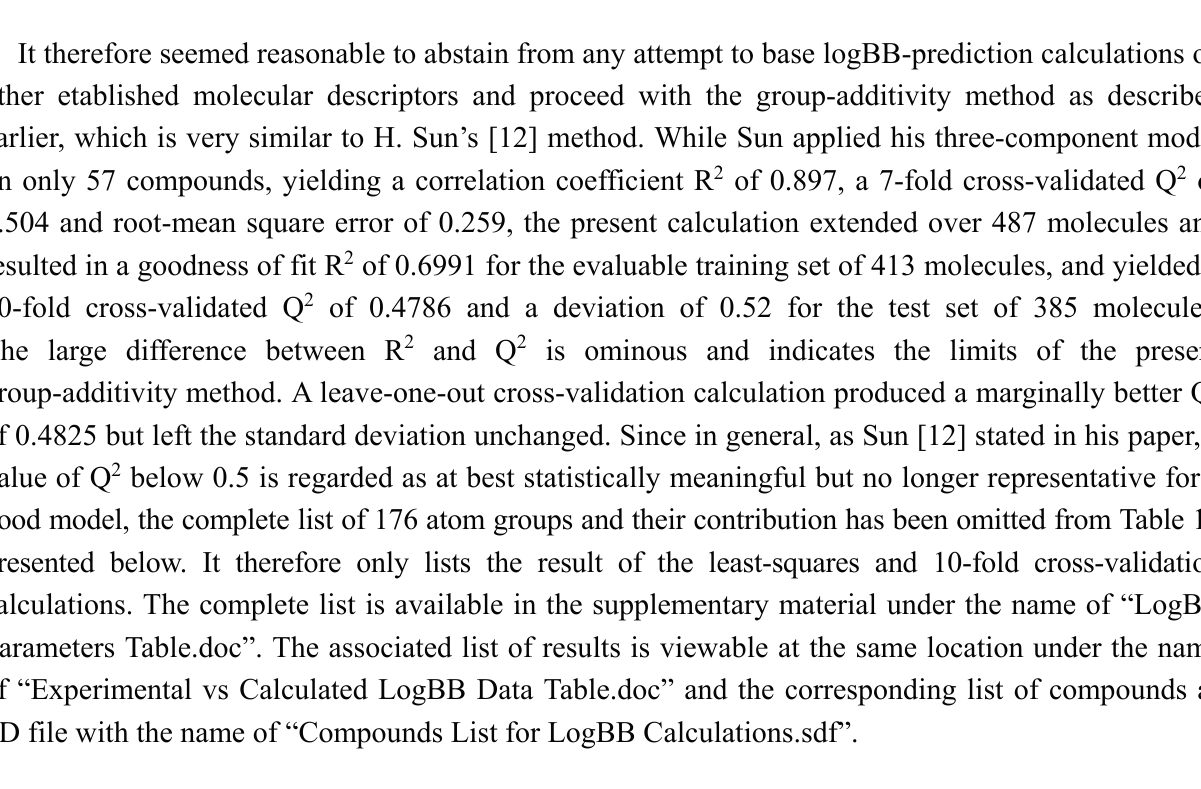
Figure 22. Correlation diagram of molecular polarizability against logBB (N = 49, R 2 =